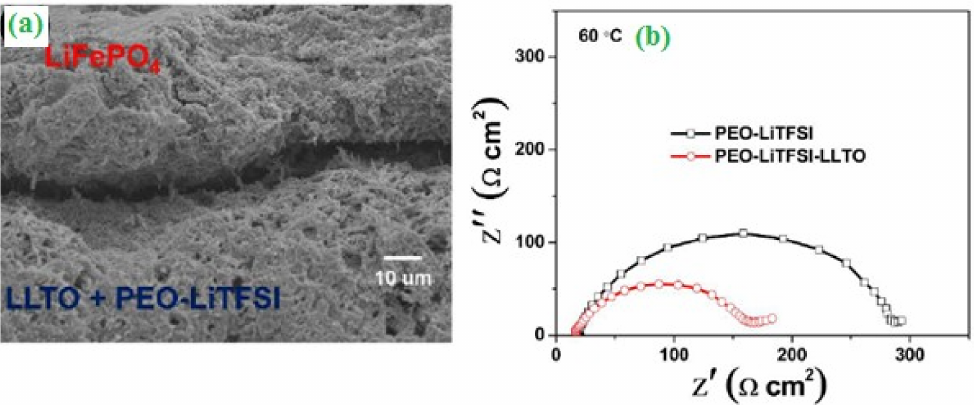
Figure 4. ( a ) The cross-sectional SEM image of the polyethyleneoxide-LiC 2 F 6 NO 4 S 2 -Li 0.33 L 0.557 TiO 3 /lithium ferrophosphate (PEO–LiTFSI–LLTO/LiFePO 4) and PEO–LiTFSI–LLTO-O/LiFePO 4 interface ( b ) The impedance spectra of the Li/PEO–LiTFSI/Li and Li/PEO–LiTFSI–LLTO/Li symmetric cells at 60 °C. Reprinted with permission from [64]. Copyright (2019), American Chemical Society.